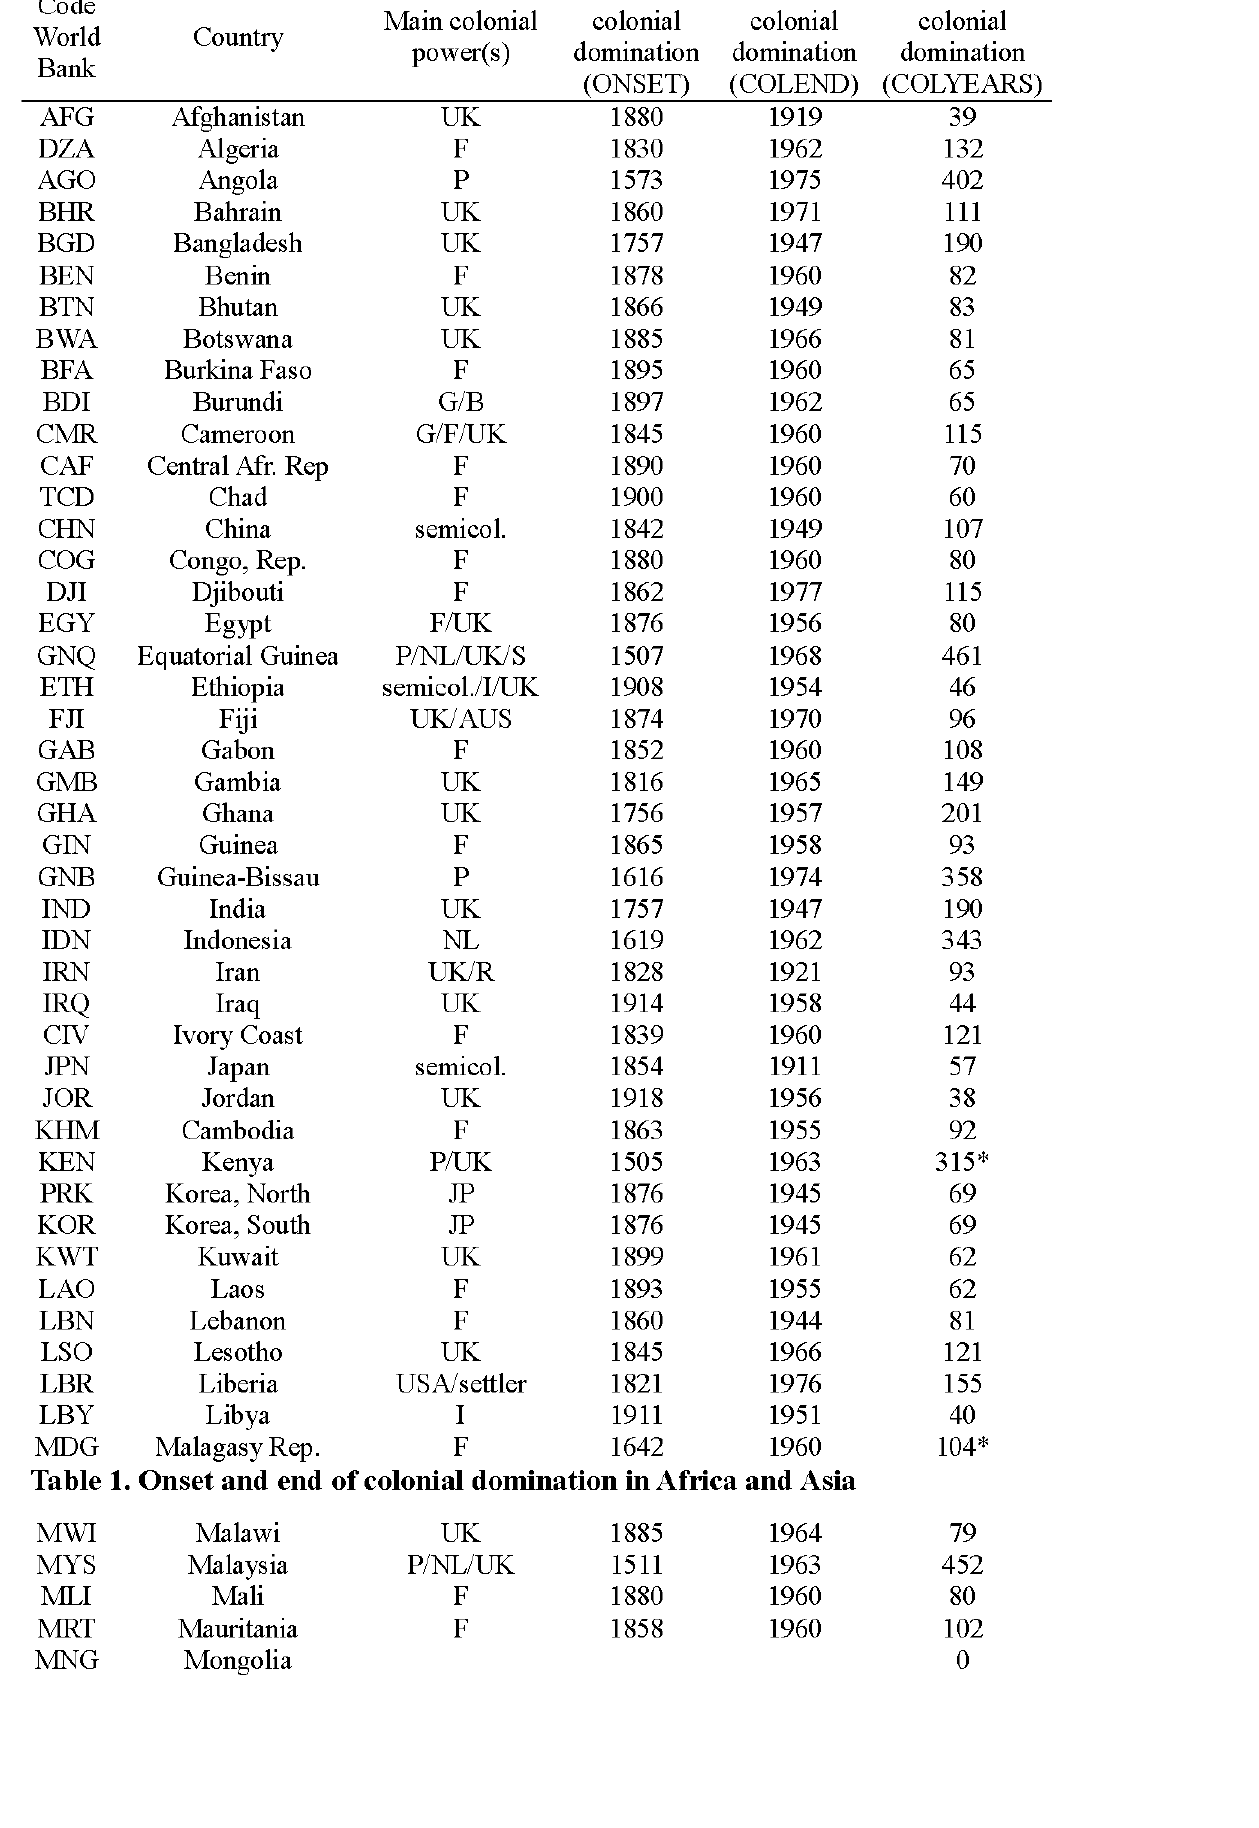
Table 1. Onset and end of colonial domination in Africa and Asia Code